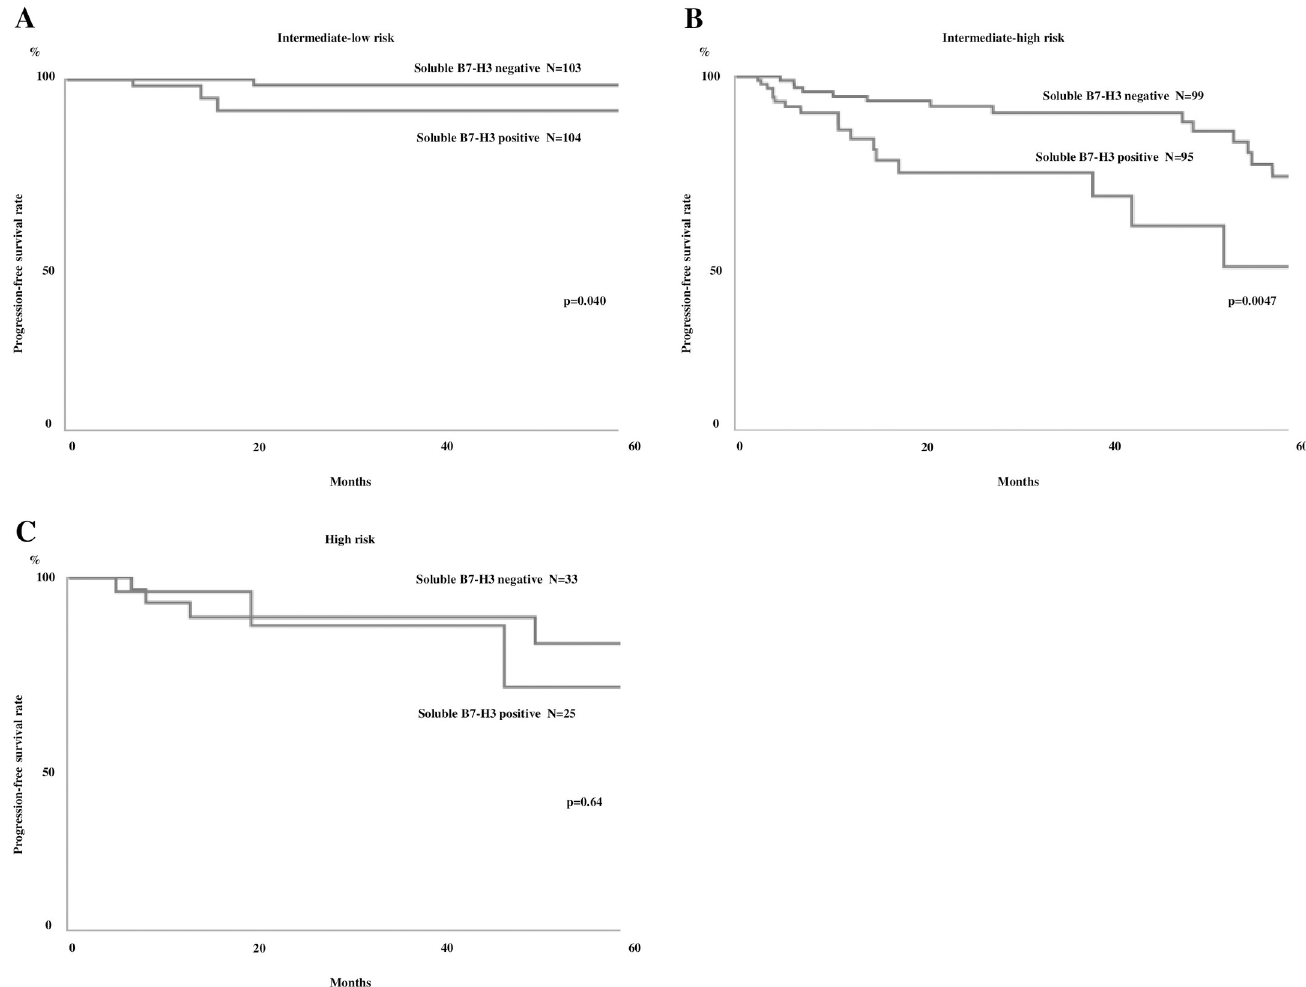
Fig 4. PFS rate curves for NMIBC patients classified by the EORTC risk table for progression all the groups were further divided according to the presence of sB7-H3. Figures show the intermediate-low (A), intermediate-high (B) and high (C)-risk groups. The low-risk groups had no patients with progression.